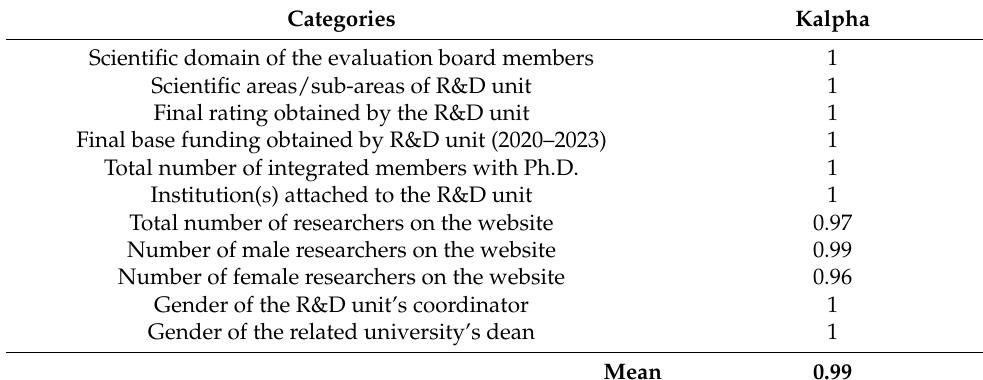
Table 3. Reliability of the categories in the data